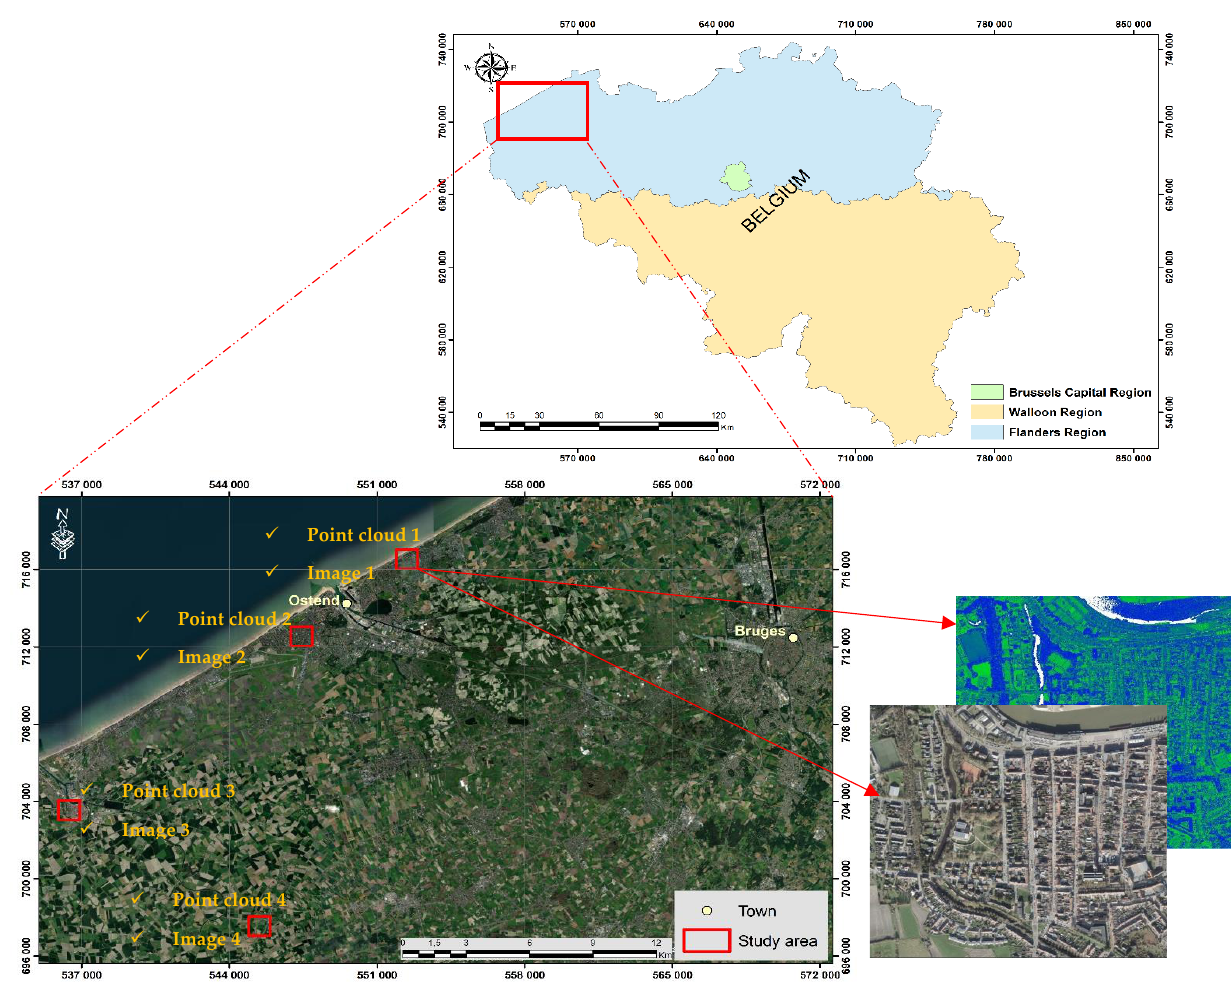
Figure 1. Location of